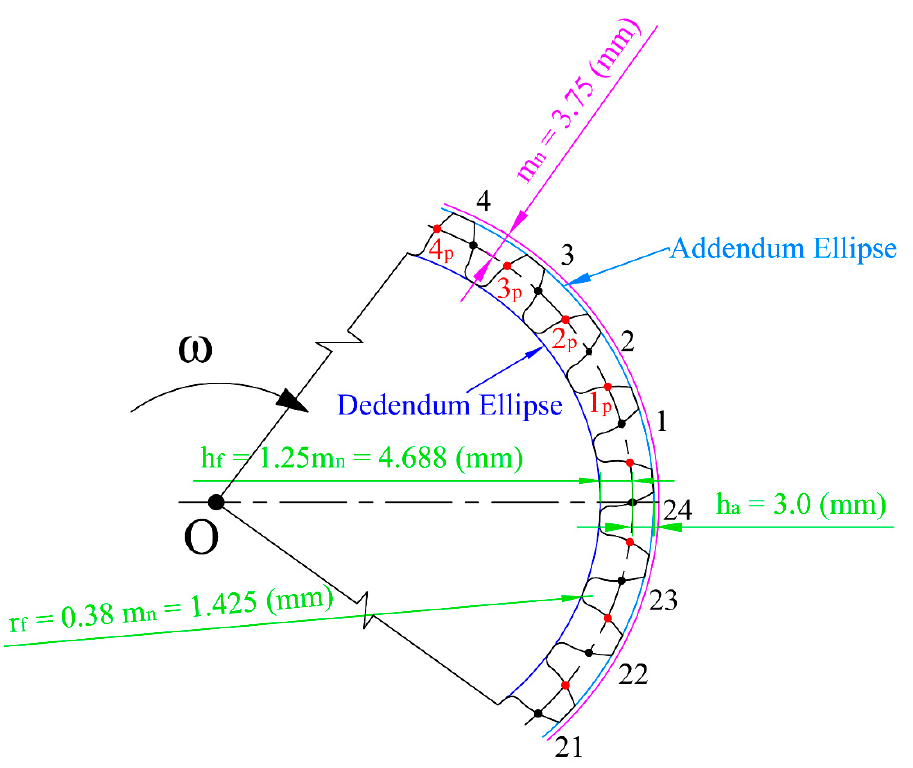
Figure 14. Dedendum and addendum of teeth. The difference between the tooth profile of the designed elliptical gear set and the tooth profile of the standard spur gear is shown in Figure 15. The profile of spur gear tooth with the number of teeth z = 24 and the module m n = m t = m = 3.75 mm is drawn using black color. The profile of the tooth denoted by the number 6 in the central point of mesh (Figure 5) is drawn using red color. At the mesh of the tooth with the intermeshing gear, the gear ratio u = 1 of the designed elliptical gear set is achieved.